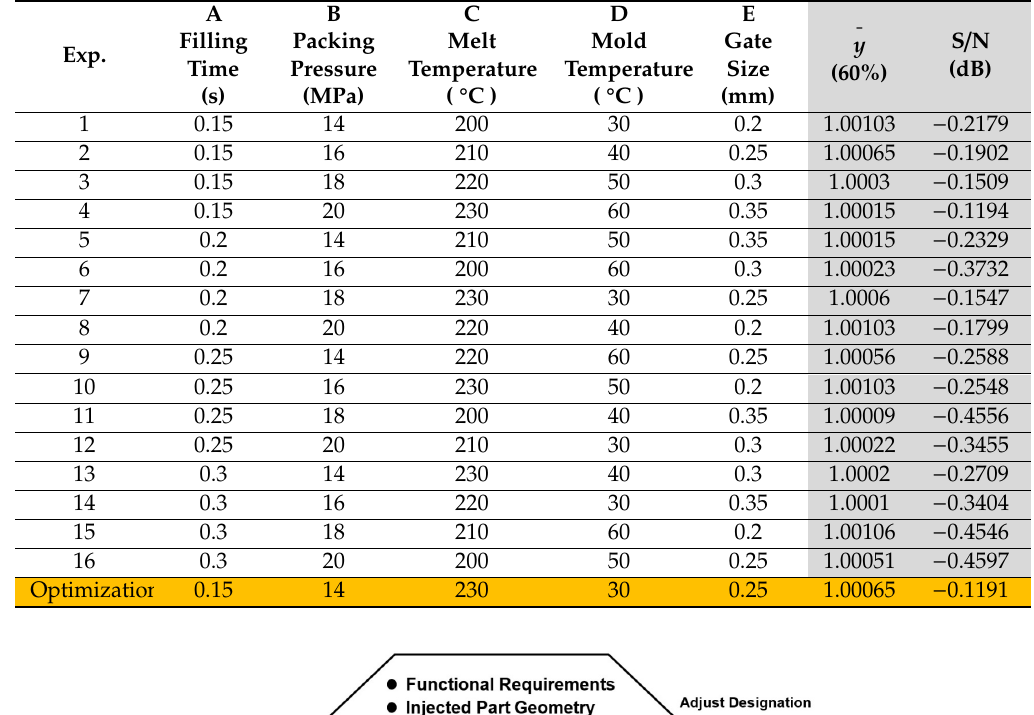
Table 3. Taguchi L 16 (4 5 ) orthogonal array.